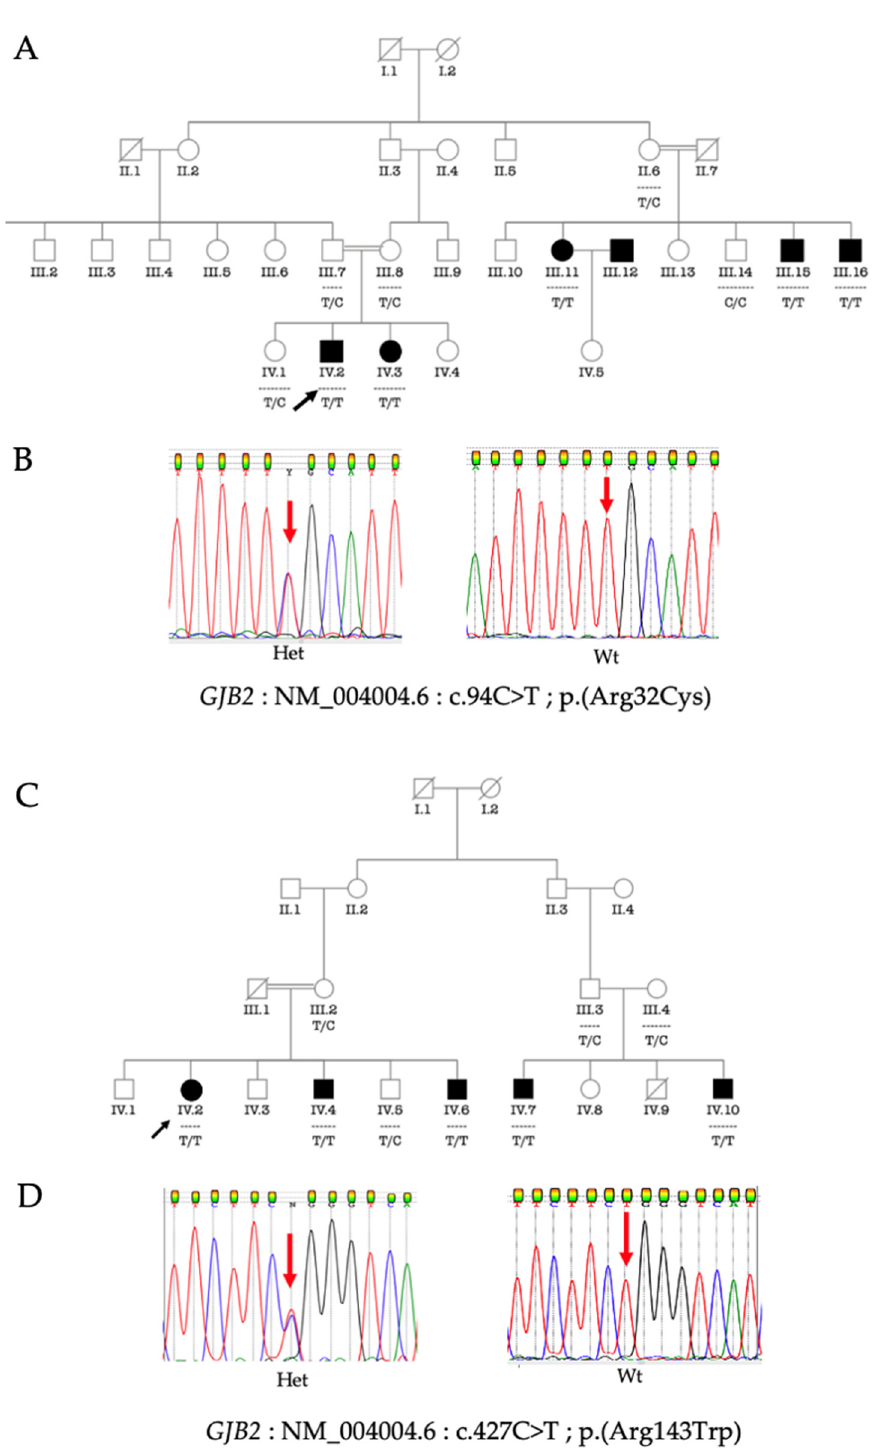
Figure 1. Pedigree of two multiplex families segregating HI and bi-allelic GJB2 : c.94C>T: p.(Arg32Cys) and GJB2 : c.427C>T: p.(Arg143Trp), respectively; black arrow indicates the proband ( A , C ). Electropherograms showing the reference and the pathogenic allele ( B , D ). The red arrows indicate the nucleotides affected by the variant. Het, heterozygous for the variant allele; Wt, wild type (homozy- gous for the reference allele) ( B , D